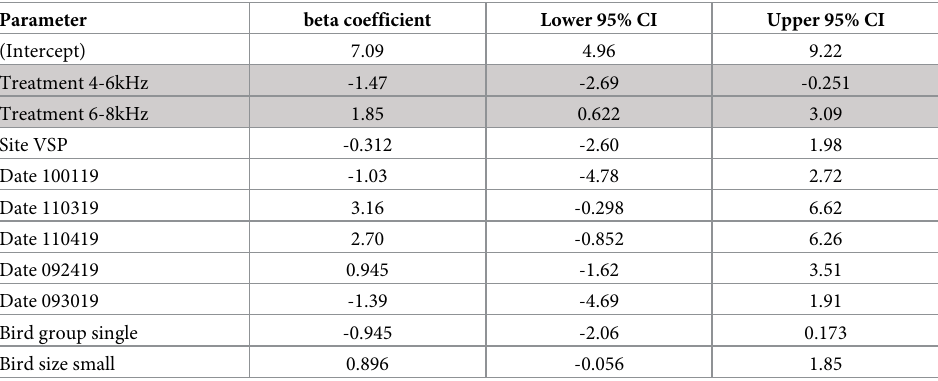
Table 4. Overall velocity model-averaged parameter estimates.